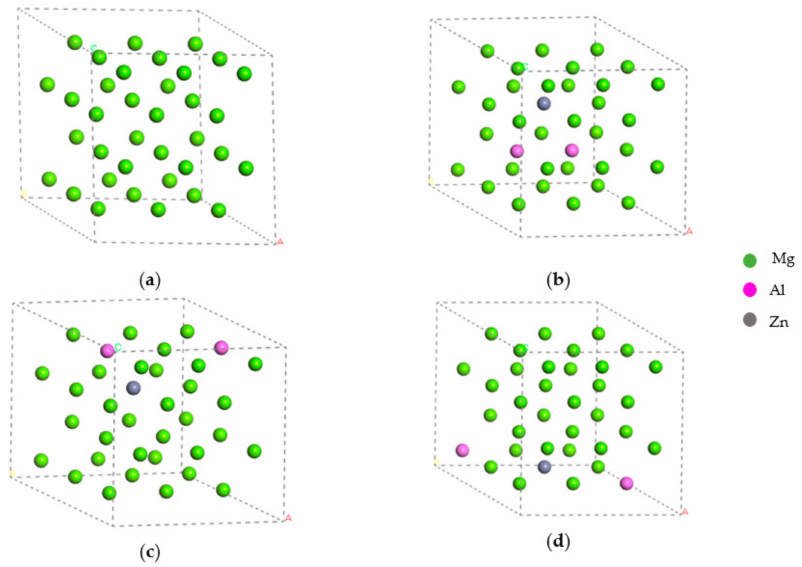
Figure 6. Pure Mg and Mg alloy Mg-Al-Zn with different positions: ( a ) Mg, ( b ) Mg-Al-Zn, ( c ) Mg-Al- Zn*, and ( d ) Mg-Al-Zn**.